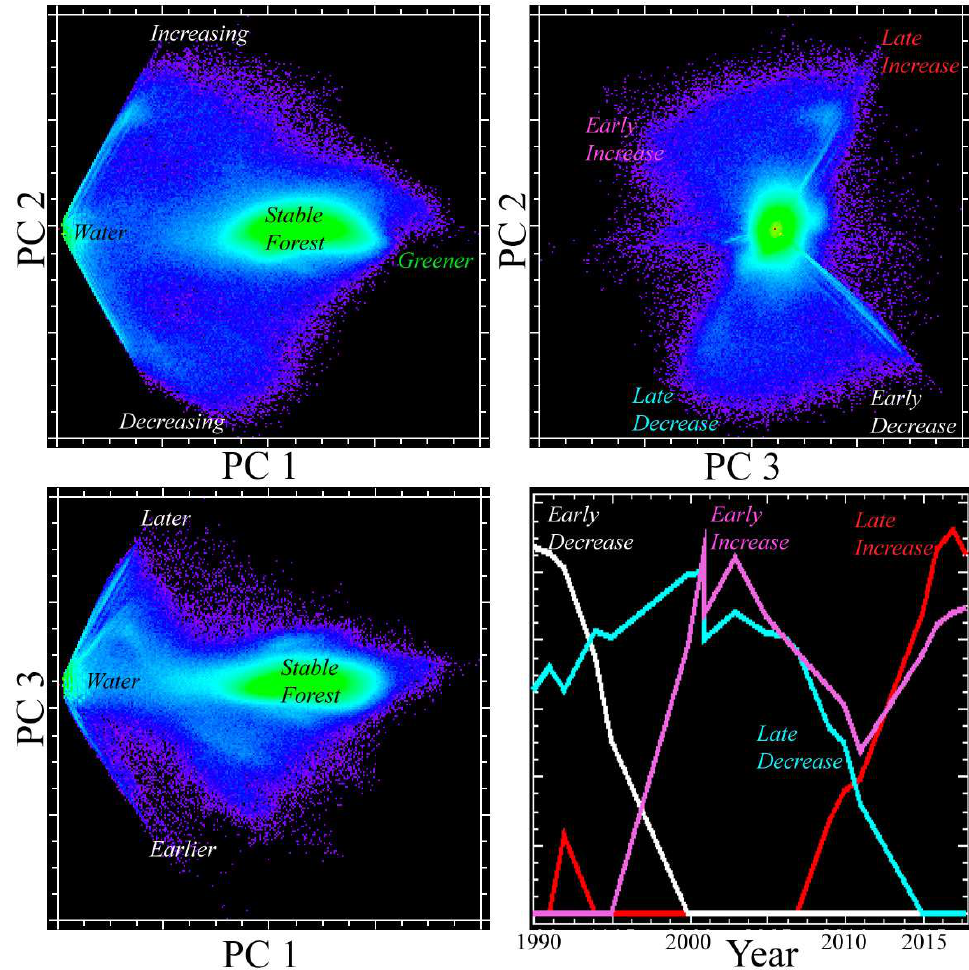
Figure 10. Interannual temporal feature space and endmembers for 1989–2017 annual post-monsoon Landsat vegetation fraction time series. Most profound changes in vegetation cover are related to advance and retreat of shorelines, riverbanks and channel networks. Bank erosion can occur quickly, but most changes are progressive over multiple years with vegetation thinning gradually or mudflat colonization occurring by vegetation species succession. Multi-year loss and recovery are less common, but do occur in some areas.